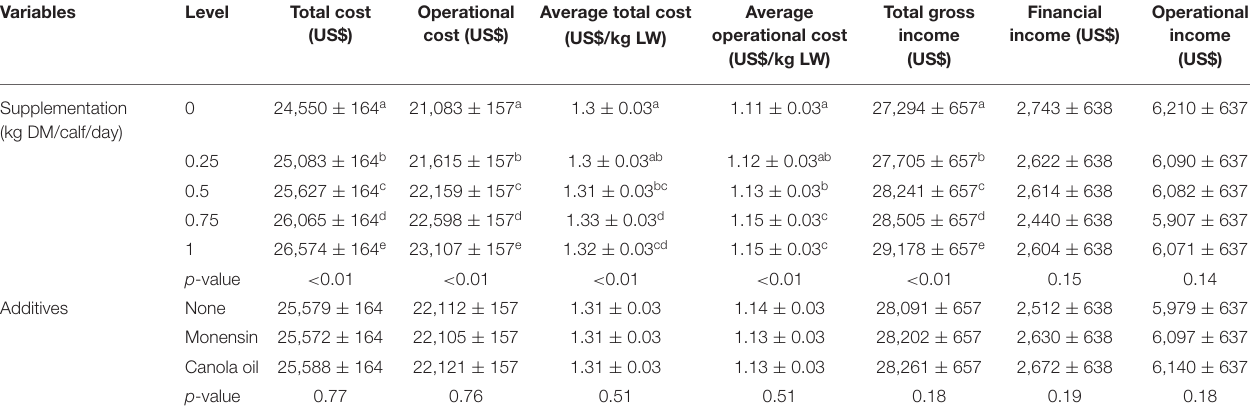
TABLE 3 | Cost and income variables concerning calf supplementation (creep feeding) and additives (monensin and canola oil) in the baseline scenario (stocking rate of 0.7 LU/ha).